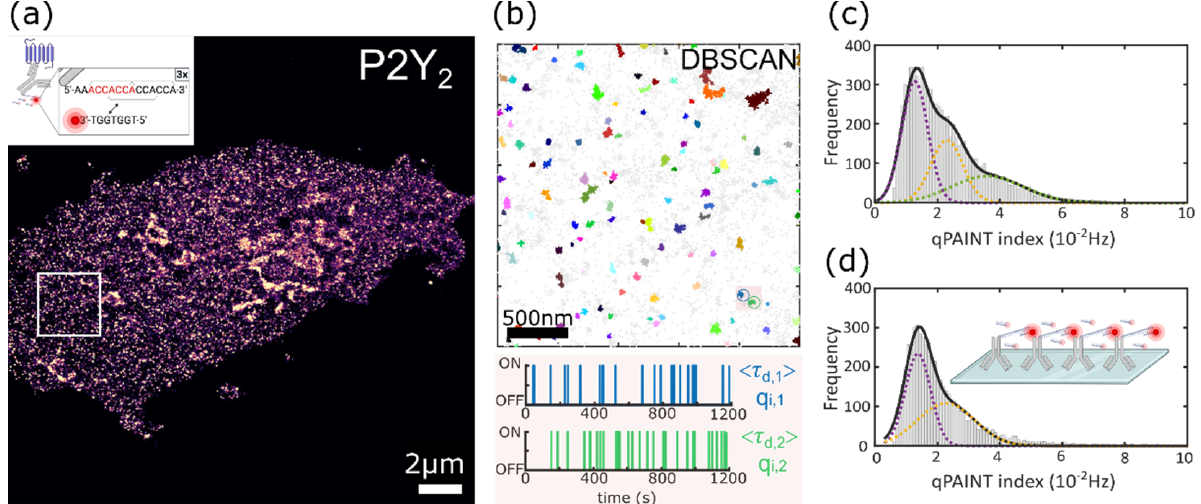
Figure 1. qPAINT calibration to determine qi . ( a ) Representative rendered DNA-PAINT image of P2Y 2 proteins in an AsPC-1 cell. Inset shows a schematic representation of DNA docking and imager strand sequences displaying the 3 × repeat binding motif (created with BioRender.com). White box indicates ROI for subsequent cluster analysis. ( b ) DBSCAN cluster analysis output for ROI indicated in ( a ). Non-clustered points are shown in grey. Box represents clusters used for subsequent single molecule on-off time series. ( c ) Histogram of internal calibration qPAINT indexes per cluster pooled from all data samples fit with a multi-Gaussian function. ( d ) Histogram of calibration sample qPAINT indexes per cluster from DNA coupled anti P2Y 2 antibody deposited on glass fit with a multi-Gaussian function.